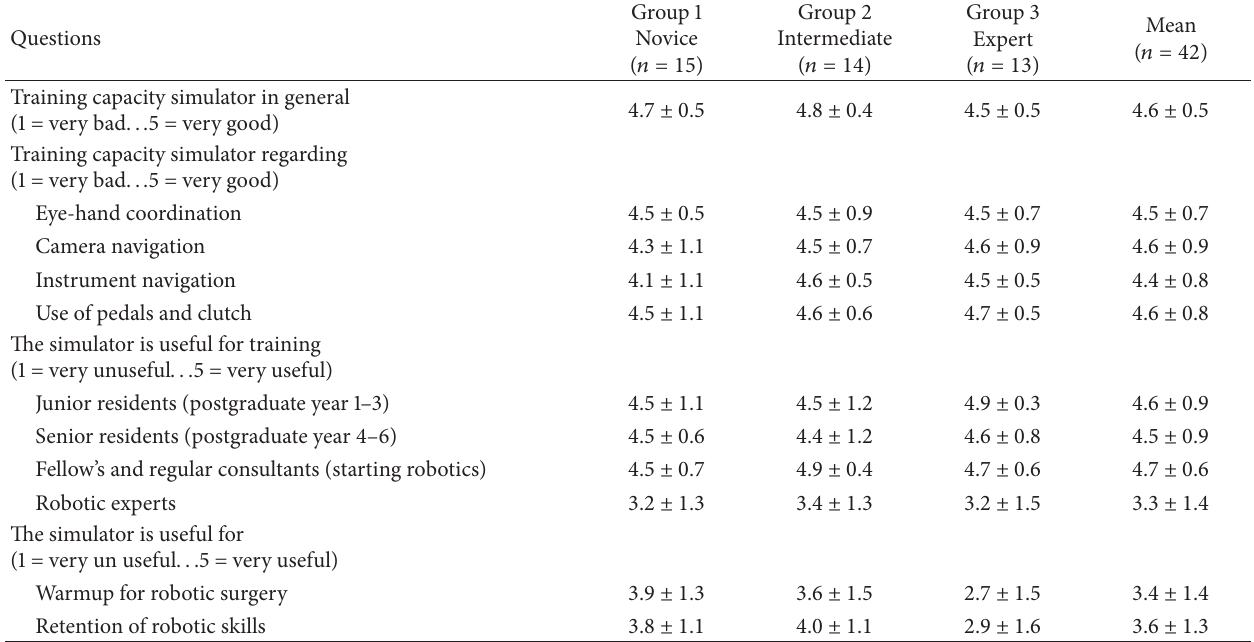
Table 4: Face validity (training